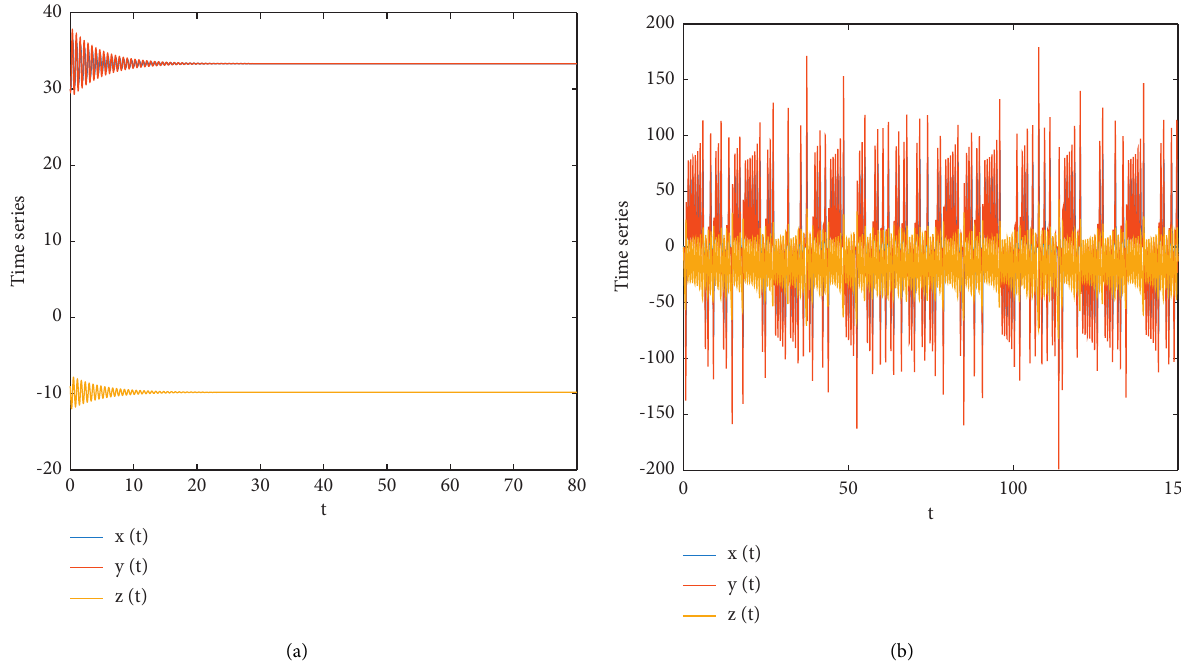
, k ) � ( 10 , 100 , 9 . 8 , 0 , 0 . 08 , 0 . 01 ) , system (1) without delay has two stable equilibria: (a) system 1 2